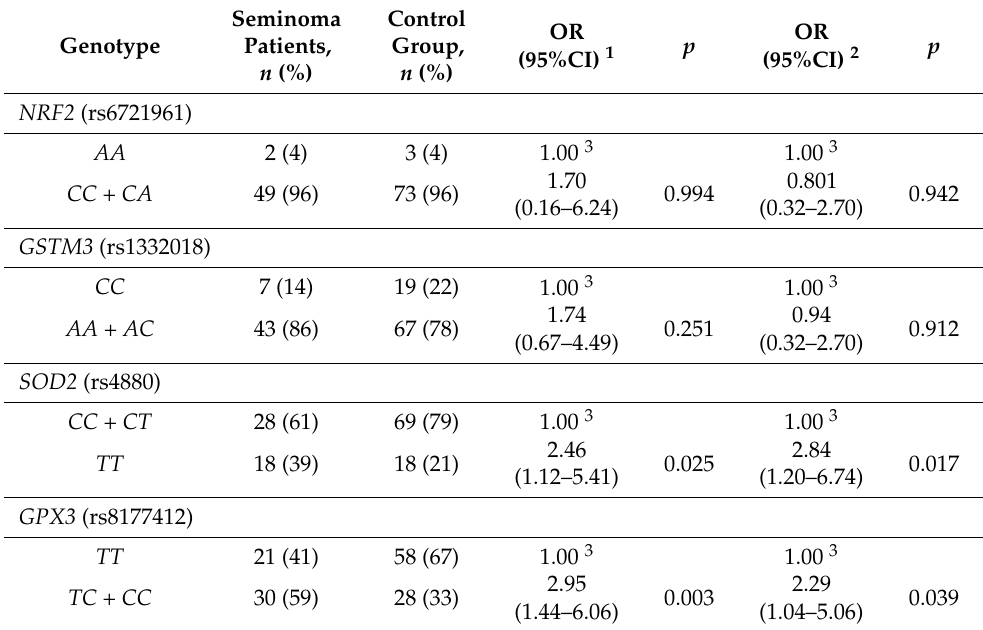
Table 4. The association of NRF2, GSTM3, SOD2 and GPX3 polymorphisms with the risk for seminoma development.